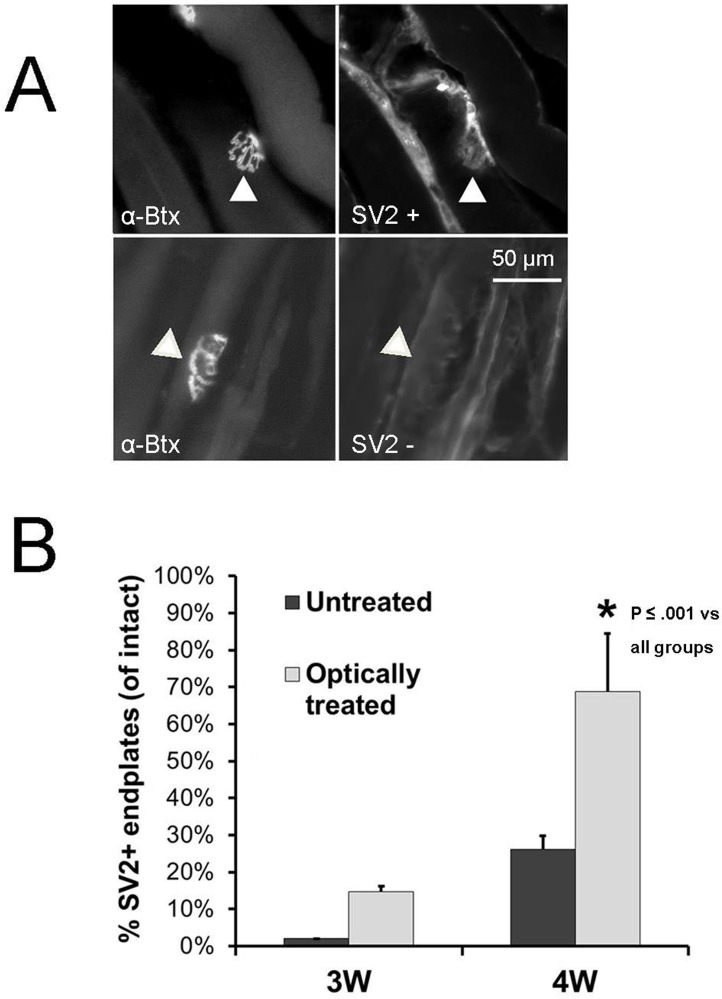
Synaptic Vesicle Protein 2 (SV2) staining to assess muscle reinnervation.A. Using the binding of fluorescent alpha bungarotoxin (α-Btx), two motor endplates are shown (top and bottom left panels). At one endplate, immunoreactivity to SV2 is found (top right, SV2+), but no similar immunoreactivity is found at the second one (bottom right, SV2-). B. Mean (+SEM) percentage of all endplates that were re-innervated (SV2+) at three and four weeks after transection and repair is shown for each group. As expected, significantly more neuromuscular junctions were SV2+ over time when untreated. Optical treatment markedly enhances the number of SV2+ neuromuscular junctions by four weeks after transection and repair * p ≤ 0.001 vs all groups.